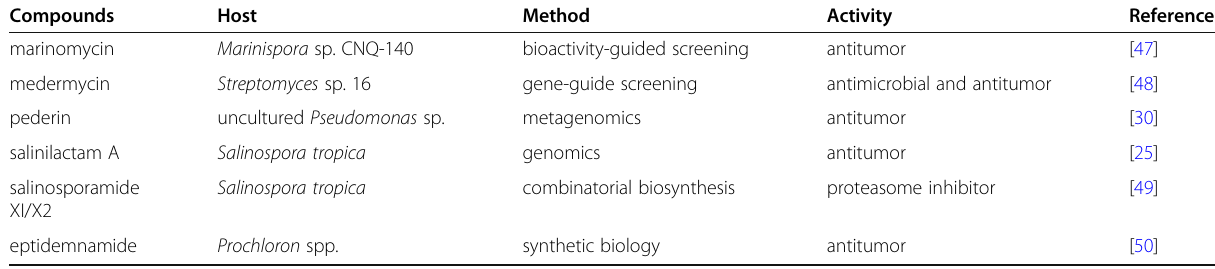
Table 1 Representative examples of MMNPs discovered by various methods Compounds